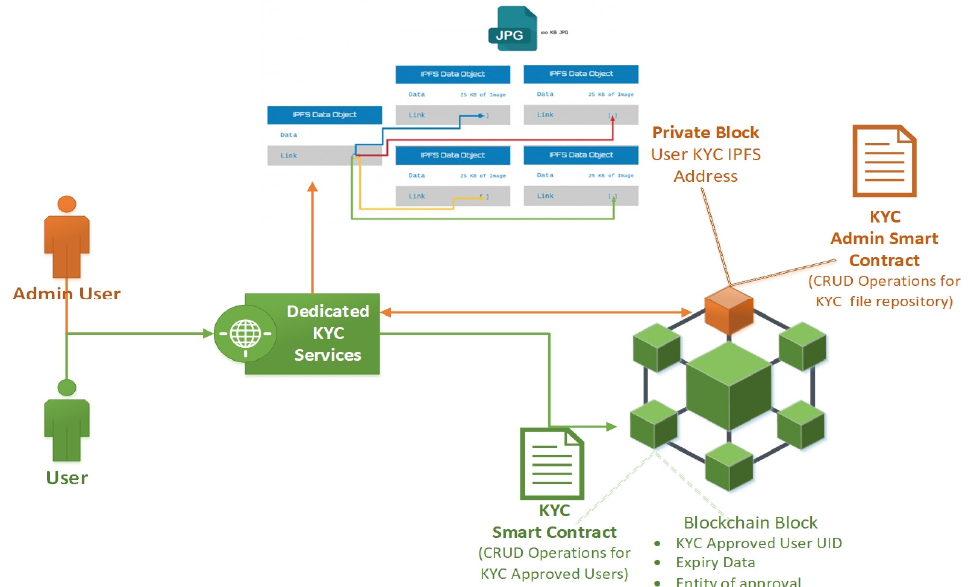
Figure 2. Public (user) and private (admin) Know Your Customer (KYC) smart contracts.